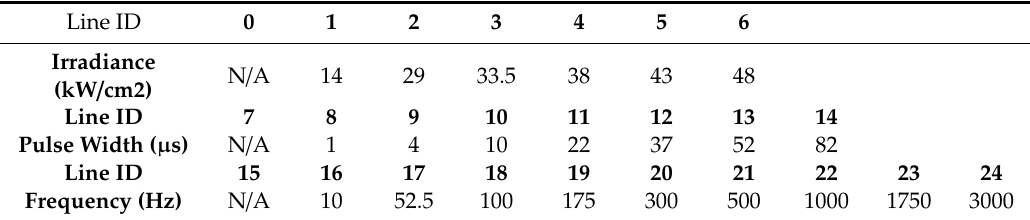
Figure 2. Tuning the laser condition via ( a ) irradiance, ( b ) pulse width, and ( c ) frequency to realize the transition between carbon deposition and He + milling of monolayer graphene. Constant linear He + beam scans with the length of 400 nm and the dose of 2 × 10 5 ions / nm were used. The typical width of the carbon deposit and cut lines are 55 nm and 40 nm, respectively. The laser pulse width and frequency were set at 10 µ s and 100 Hz, respectively, for the irradiance test shown in ( a ); the irradiance and frequency were set at 29 kW / cm 2 and 100 Hz, respectively, for the pulse width test in ( b ); the irradiance and pulse width were set at 29 kW / cm 2 and 10 µ s, respectively, for the frequency test in ( c ); and ( d ) plots the average laser power density and energy density per pulse. Dashed lines mark the threshold values between depositions and mills. Table 1. Detailed laser conditions of the three tests shown in Figure 2. The base parameter was set at 29 kW / cm 2 , 10 µ s, and 100 Hz. Three exposure parameter series were conducted: laser power density, pulse width, and frequency.